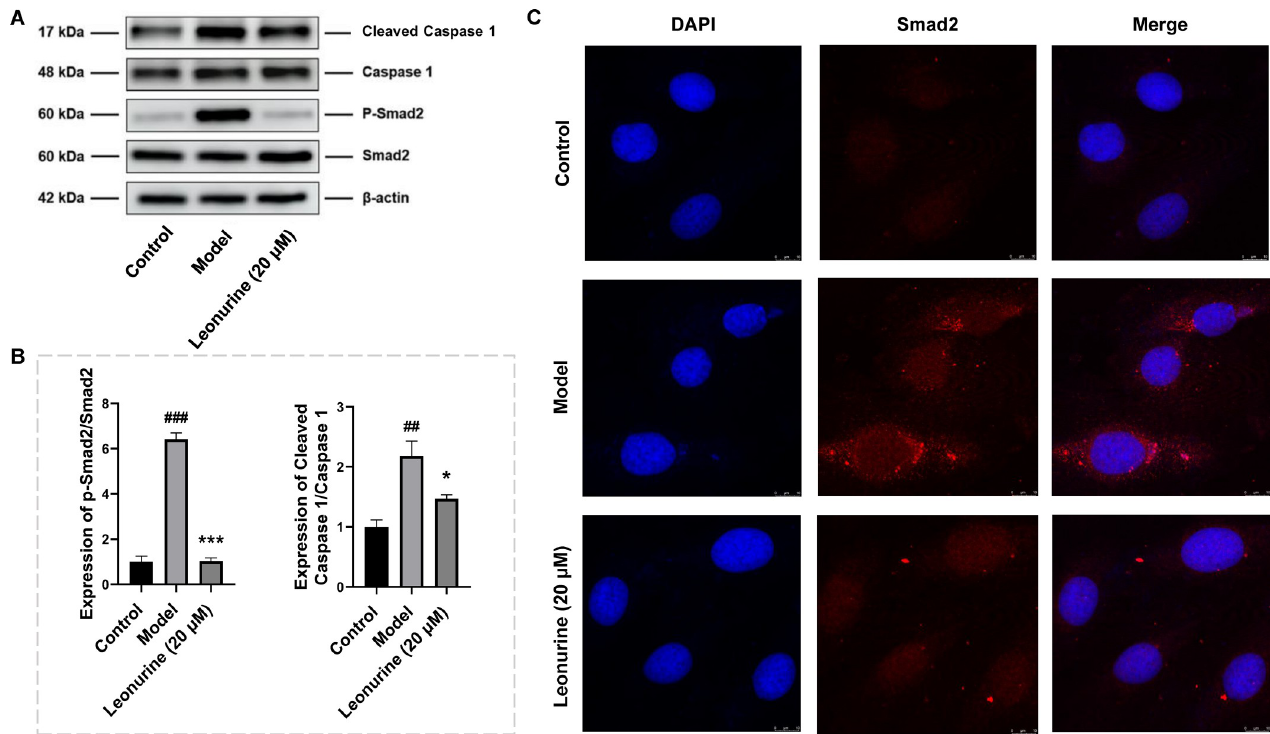
Fig 9. Leonurine inhibited pyroptosis by regulating TGF- β /Smad2 signalling pathway in H9c2 cells stimulated by TGF- β . (A) Compared to H9c2 cells induced by TGF- β for thirty minutes, leonurine decreased the expressions of Smad2 phosphorylation and cleaved Caspase 1 (B) The ratio of Smad2 phosphorylation to Smad2 expression and the ratio of cleaved Caspase 1 to Caspase 1 expression. (C) The fluorescence of Smad2 protein was detected under a confocal laser scanning microscope. Compare to TGF- β induced model group, the intensity fluorescence of Smad2 protein was weakened after leonurine treatment. #P < 0.05, ##P < 0.01, model group vs. control group; � P < 0.05, ��� P < 0.001, 20 μ M leonurine group vs. model group.